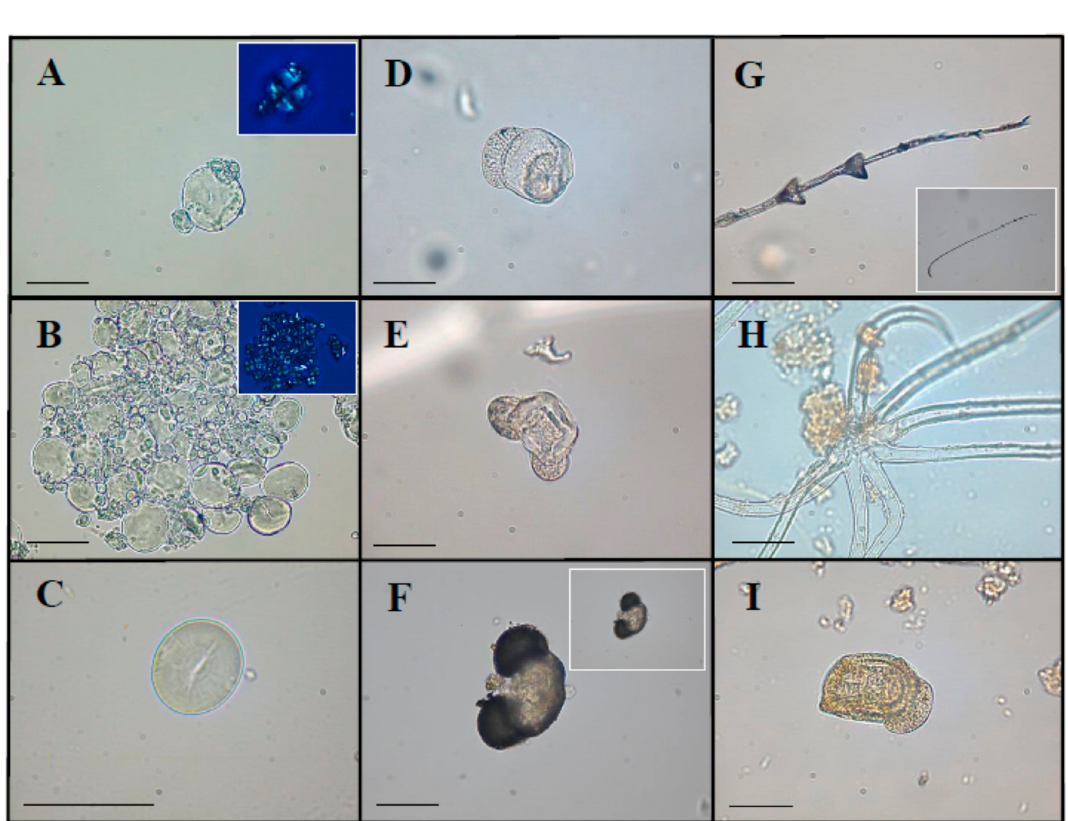
Figure 2. Mosaic of representative micro-debris found in Phoenician dental calculus by optical microscopy. ( A ) Triticeae starch granules and relative polarized image; ( B ) Aggregate of Triticeae starch grains and relative polarized images; ( C ) Modern reference of Triticum dicoccum L. starch; ( D , E ) Gymnosperm pollen grains; ( F ) Modern reference of gymnosperm pollen; ( G ) Fragment of feather barbule typical of Anseriformes; ( H ) Multiradiate non-glandular trichomes and unidentified fibers; ( I ) Damaged gymnosperm pollen grain. Each scale bar represents 40 µm.